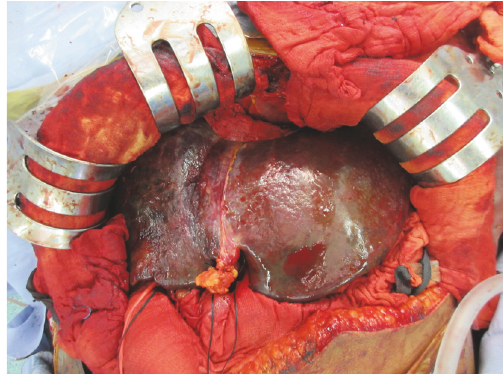
Figure 5: Pretransplantation CT scan showed a large area of infarction in the right lobe of the liver (arrows). Figure 6: Gross appearance of the patient’s liver during liver